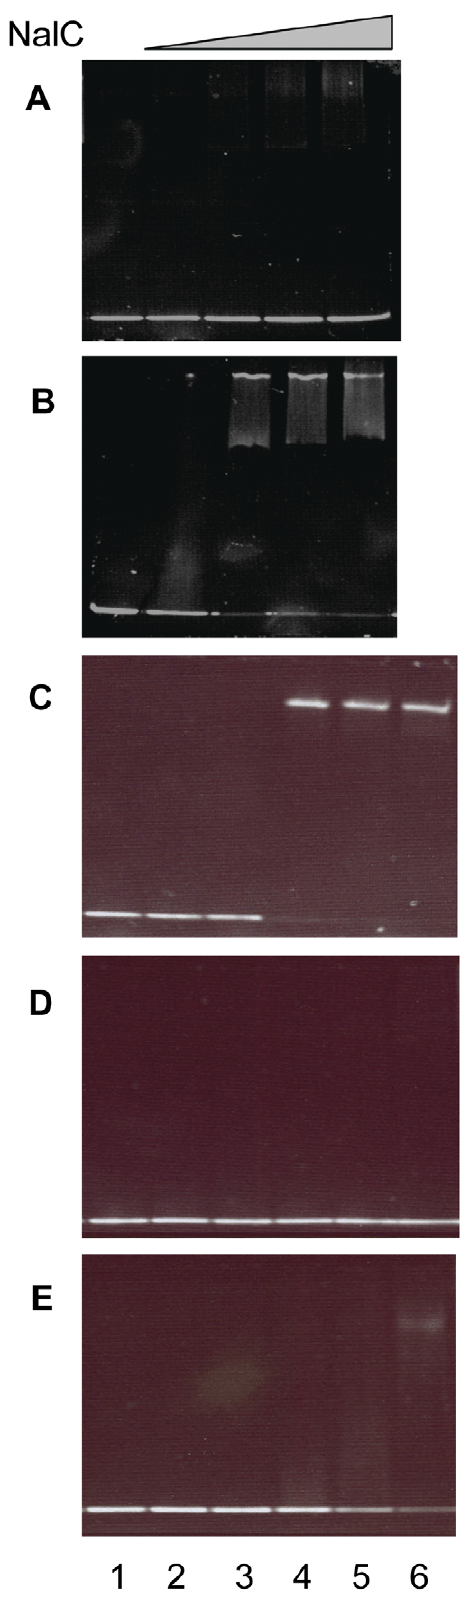
Figure 3. Identifying the NalC binding site upstream of PA3720- armR . A–B) Mobility shift assay in which 50 ng of A) the 107-bp PA3720-distal DNA fragment (sequence delineated by